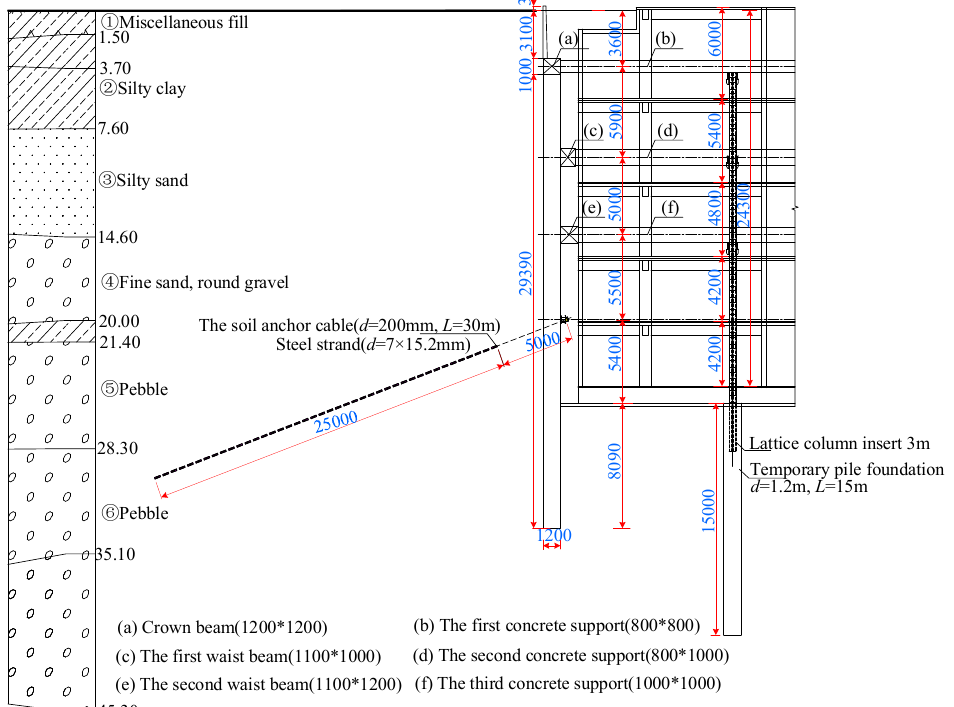
Figure 1. Sectional drawing of the new foundation pit.